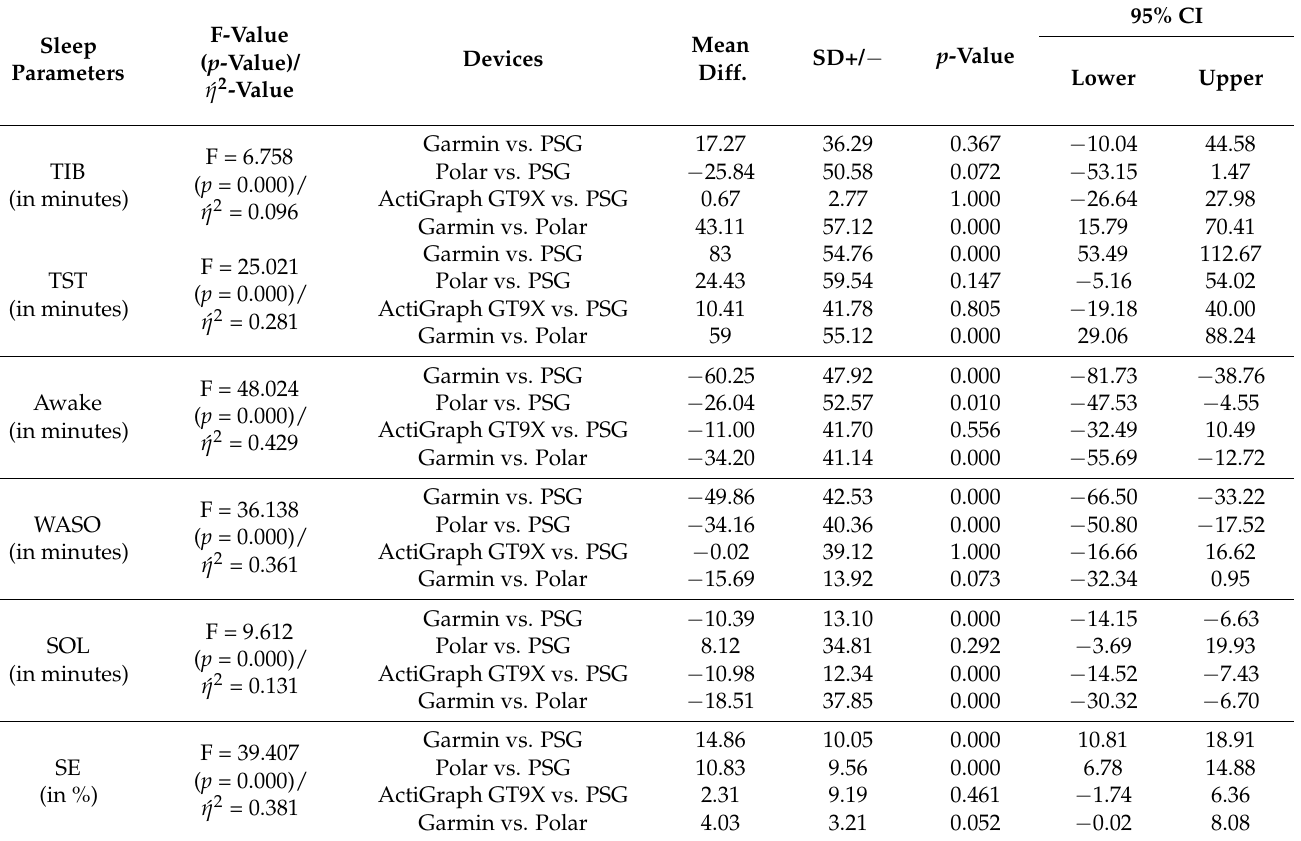
Table 4. Sleep parameters of Garmin Forerunner 945, Polar Ignite and ActiGraph GT9X and their comparison with the gold standard PSG using one-way ANOVA ( n =